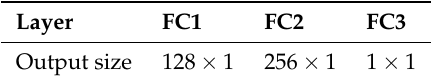
Table 3. Classification component network